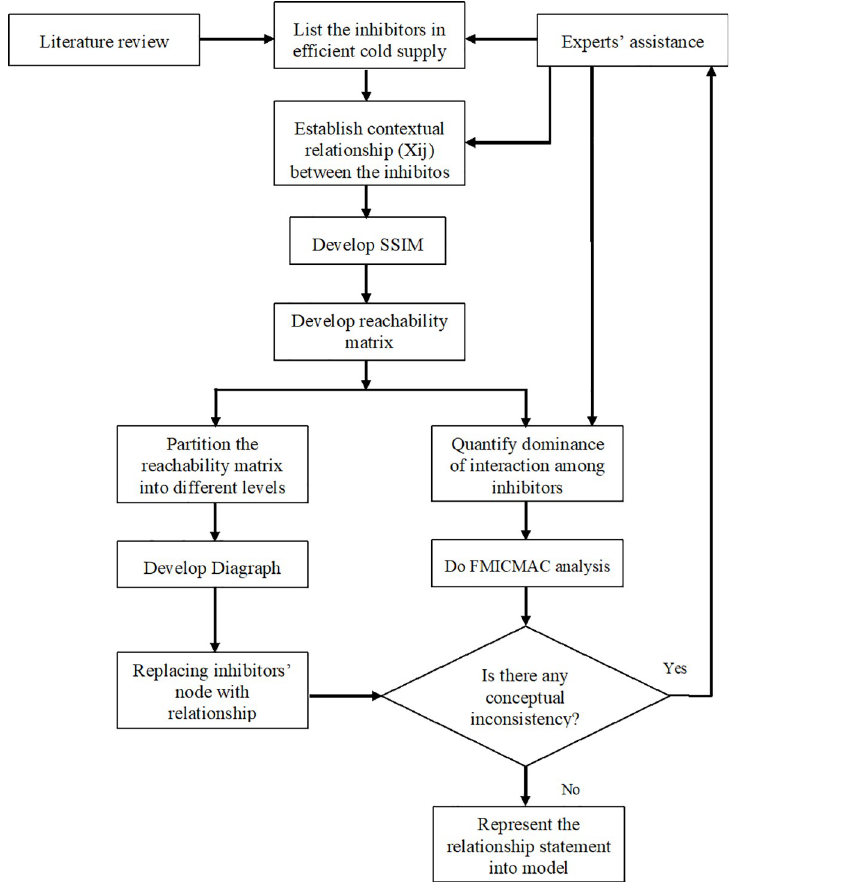
Fig 1. Flow diagram illustrating the FISM procedure (adopted from Joshi et al.,